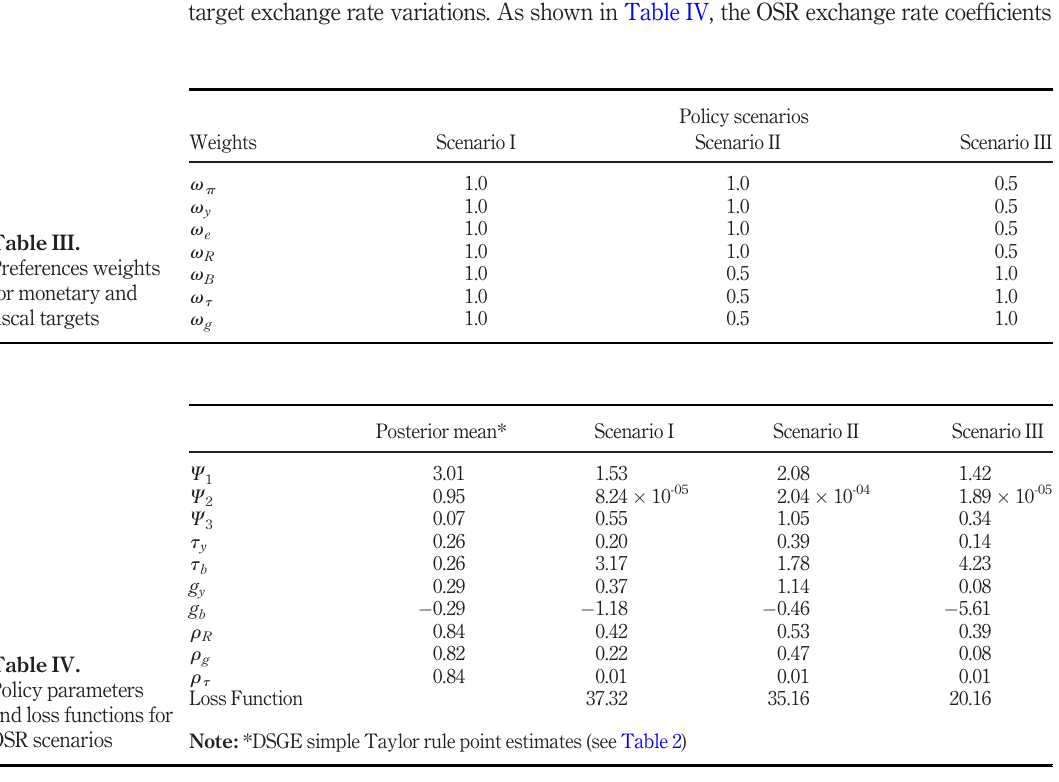
Table IV. Policy parameters and loss functions for OSR scenarios